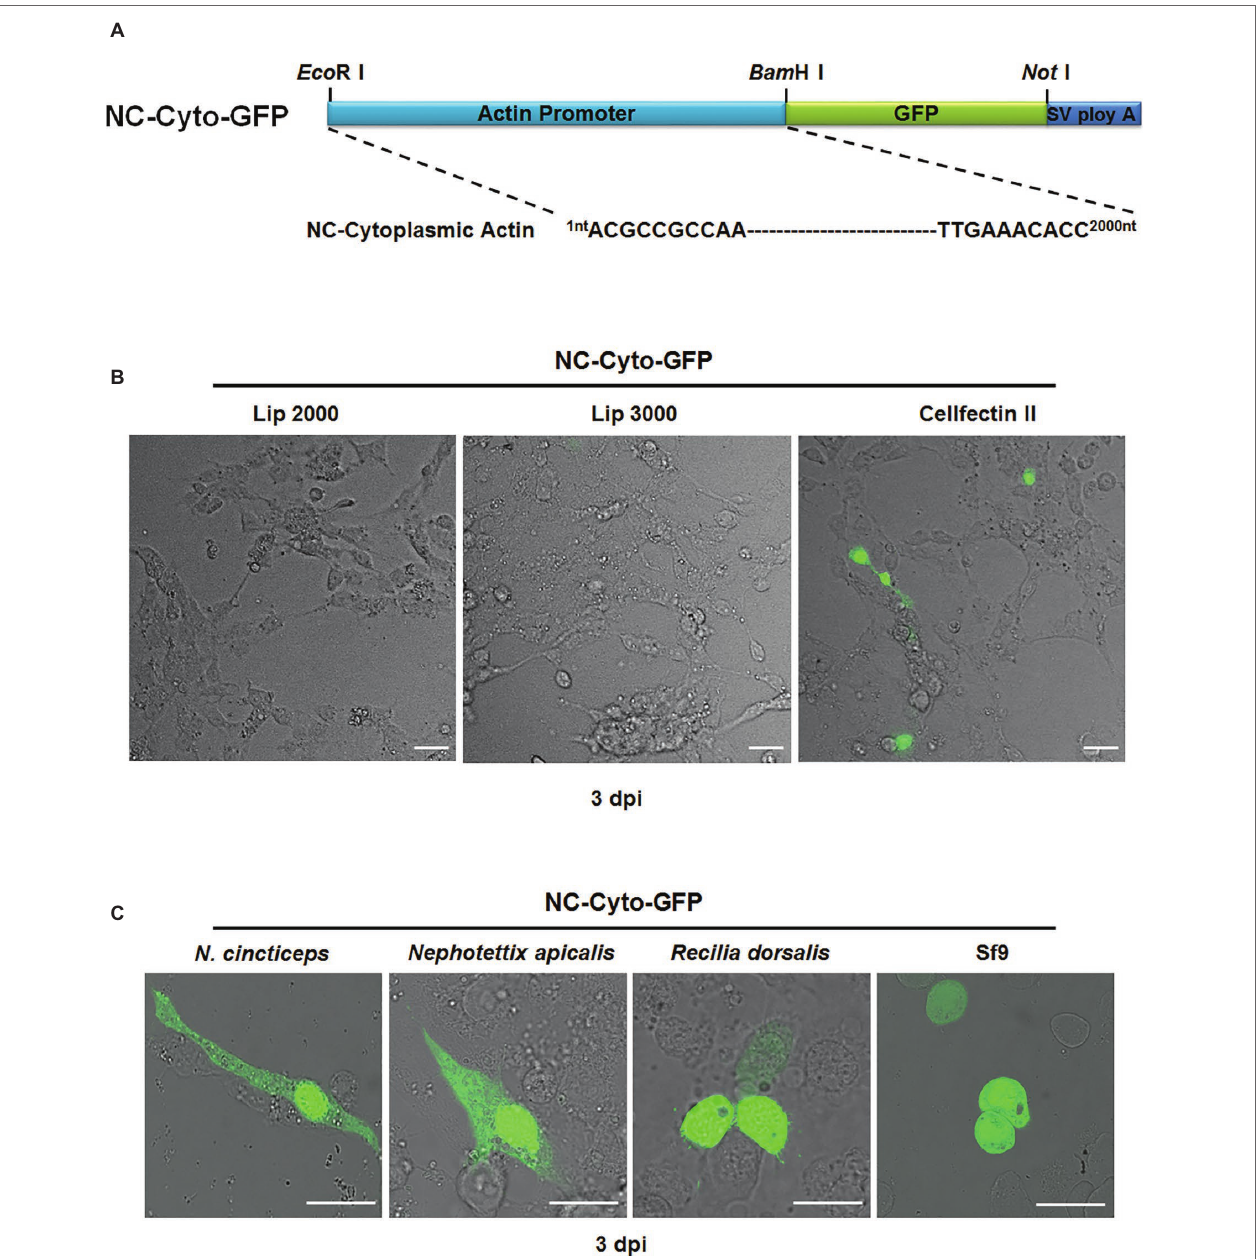
FIGURE 1 | Evaluation of the efficiency of the N. cincticeps cytoplasmic actin promoter in N. cincticeps , N. apicalis , R. dorsalis , and Sf9 cells. (A) Schematic representation of the NC-Cyto-GFP construct. (B) Cultured N. cincticeps cells transfected with NC-Cyto-GFP via different liposome reagents observed 3 days post transfection. (C) Various insect cell culture lines, including N. cincticeps , N. apicalis , R. dorsalis , and Sf9 cells, transfected with NC-Cyto-GFP and observed 3 days post transfection. Scale bar: 20 μm. SV poly A indicates Simian vacuolating virus 40 poly A